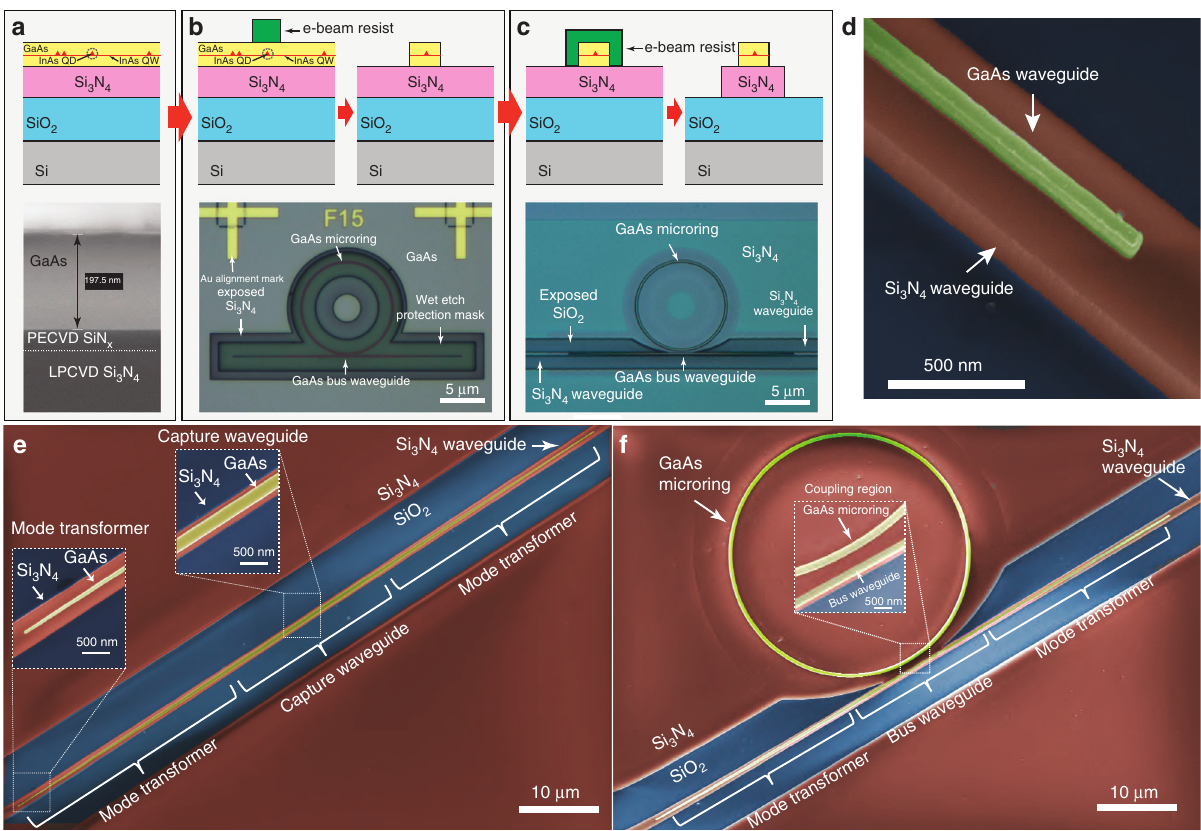
Fig. 3 Device fabrication. a Top: schematic of the bonded wafer stack used in fabrication, consisting of a top III – V layer, containing InAs QDs, that is directly bonded on top of a Si/3 μ m SiO 2 /550 nm Si 3 N 4 stack. Bottom: cross-sectional scanning electron microgaph (SEM) of bonded wafer stack. The ≈ 30 nm SiN x layer was grown on the GaAs wafer surface prior to bonding. b Top: GaAs device lithography and etching steps. Bottom: optical micrograph of etched GaAs microring resonator and bus waveguide. Au aligment marks used for registered electron-beam lithography are visible. A wet etch protection resist mask (not depicted in the schematic — Supplementary Note 2) is also visible. c Top: Si 3 N 4 waveguide lithography (aligned to the previously etched GaAs device) and etching steps. Bottom: optical micrograph of GaAs microring resonator and bus waveguide, and underlying Si 3 N 4 waveguide. d False-color SEM of tip of mode-transformer geometry, common to both devices in ( e , f ). e False-color SEM of fabricated GaAs waveguide (yellow) on top of Si 3 N 4 (red) waveguide. Blue regions are exposed SiO 2 . Insets show details of the mode transformer end tip and the QD photon capture waveguide. f False-color SEM of GaAs microring and bus waveguide, and underlying Si 3 N 4 waveguide. Inset shows details of the microring-bus waveguide evanescent coupling